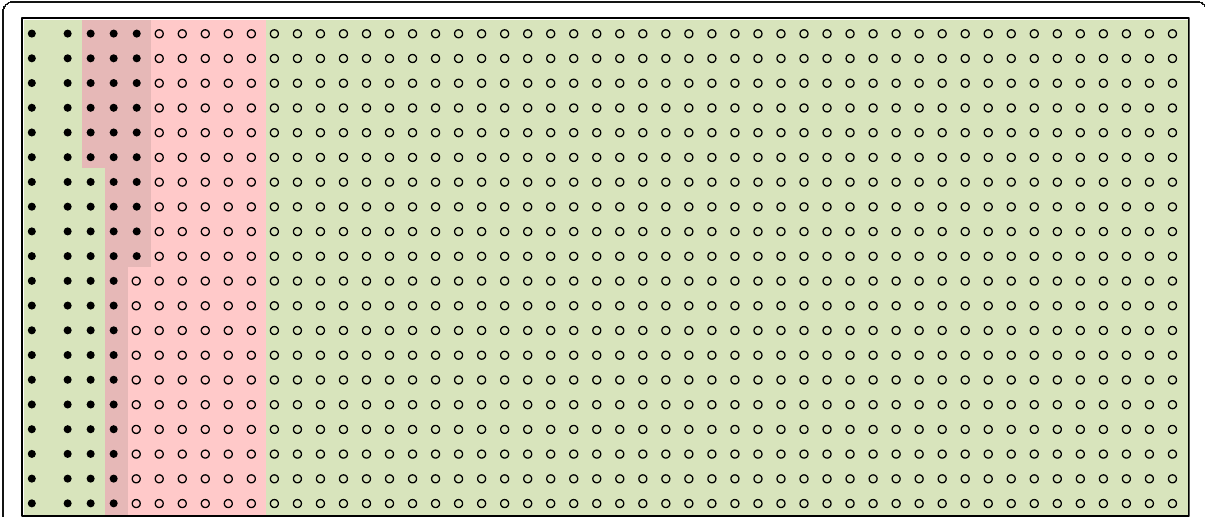
Fig. 2 Population diagram to illustrate clinical ramification of the QRISK2 score (cut-point 20%). Each circle (1000 in total) in the figure represents one male between the ages of 35 and 74 years, of whom approximately 90 will have a cardiovascular event over 10 years of follow-up (shaded circles) and 910 will not (unshaded circles). Red shaded cells indicate people deemed “ at risk ” using the QRISK2 score with a cut-point of ≥ 20%. Green cells are people deemed “ not at risk ” . These natural frequencies were derived using the reported natural frequencies in the external validation cohort for males ([4], Table 4). The externally validated C-statistic was 0.77; estimated the sensitivity 40% and specificity 88%; and prevalence of 0.09 over 10